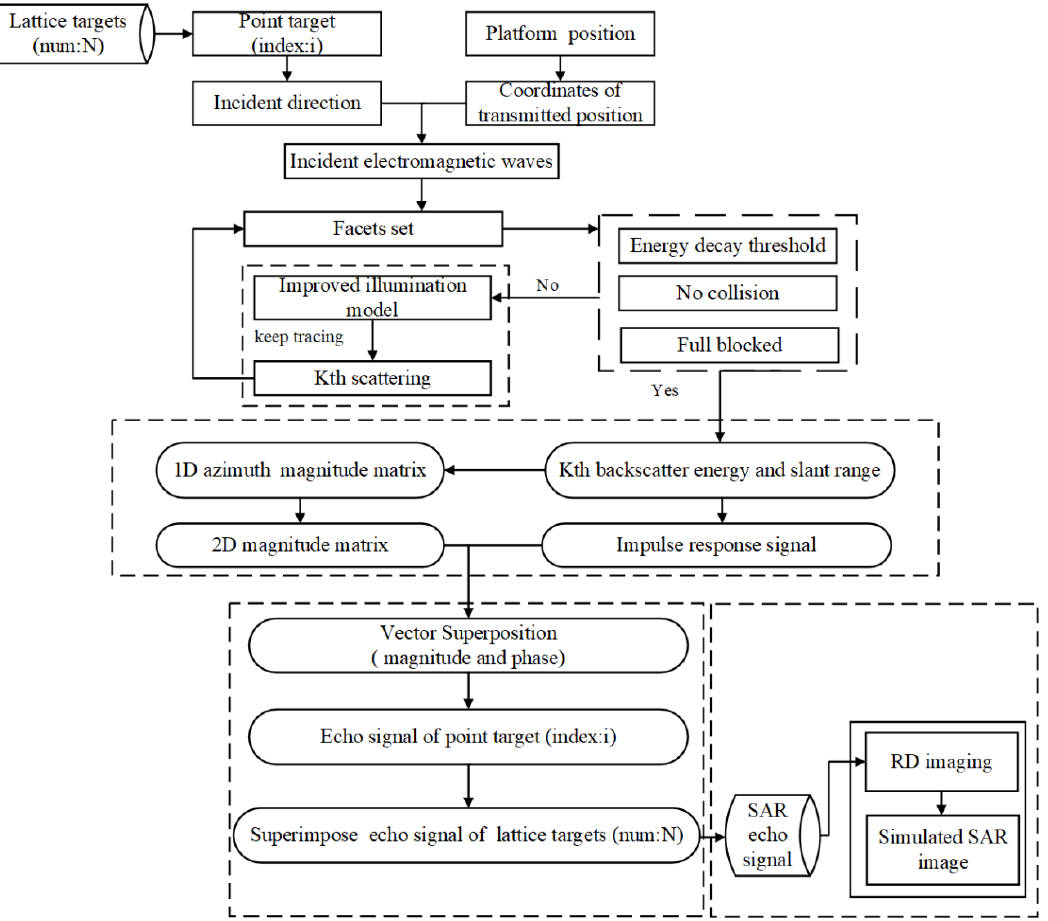
Figure 5. Process of echo time-domain simulation and imaging of lattice targets based on the ray tracing algorithm.